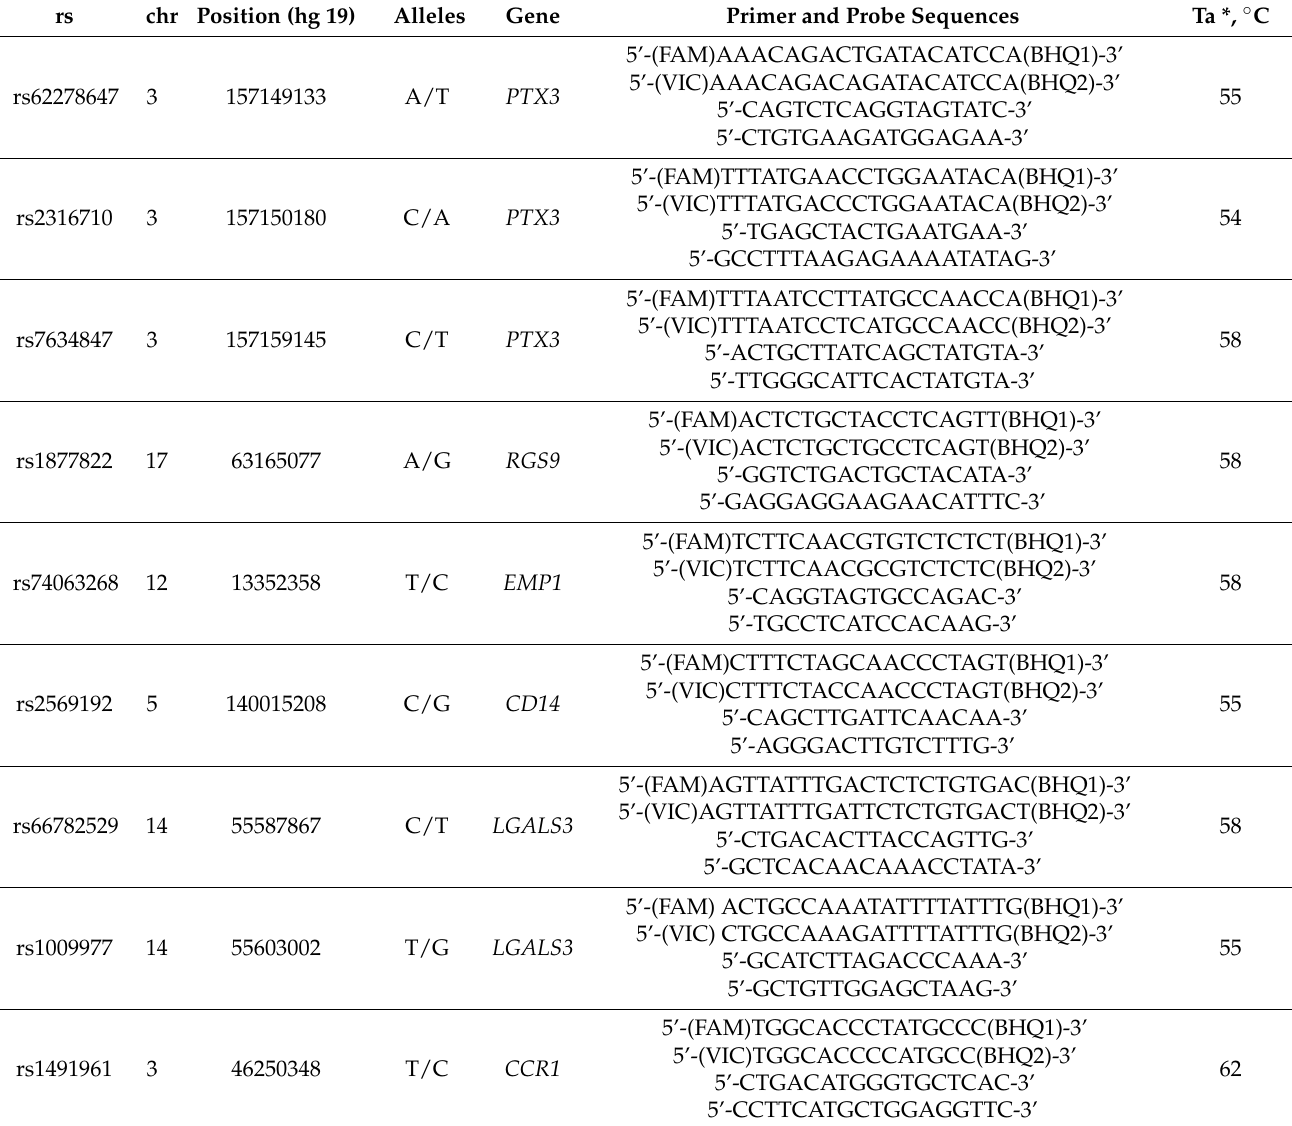
Table 1. Genomic characteristics of the polymorphisms studied, with primer and probe sequences and PCR conditions.